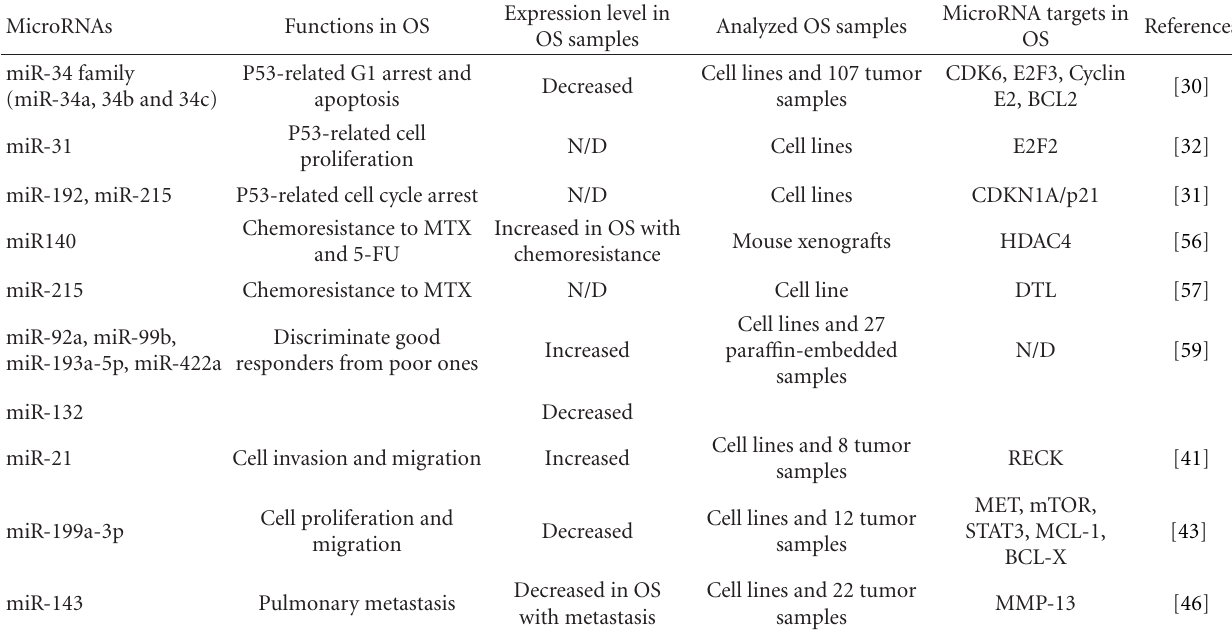
Table 1: List of microRNAs involved in regulation of